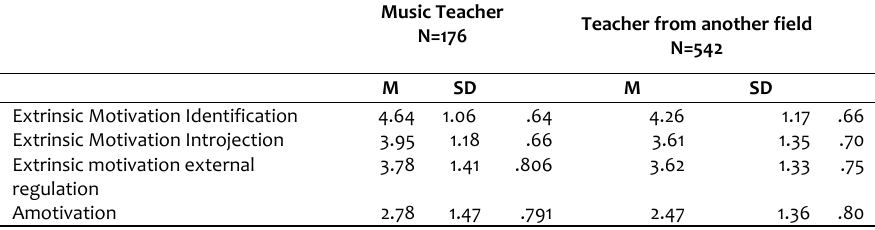
Table 2.Extrinsic Motivation and